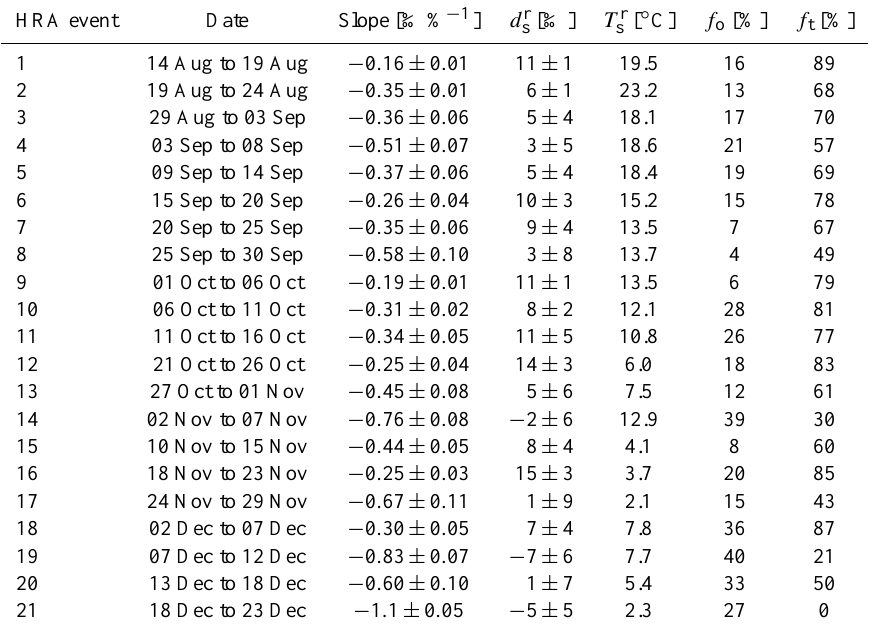
Table 5. Slope and intercept of d – h r s for HRA events. The whole HRA data set is shown in Fig. 10 in a d – h r s scatter plot. The columns show the date of the events, the slope, the diagnosed source d r s , the mean ground temperature and the ocean contribution f o during the events (obtained from the moisture source diagnostic). f t shows the transpiration fraction of the evapotranspiration flux over the continental part of the moisture source region (see Sect. 7 for more details). The statistical significance level for the slope obtained by linear regression was checked using a t test with a 98% confidence interval. The p value for the regressions of all the events is smaller than